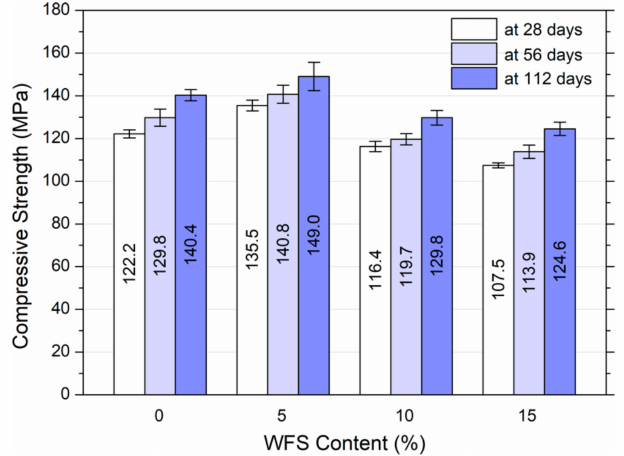
Figure 2. Compressive strength